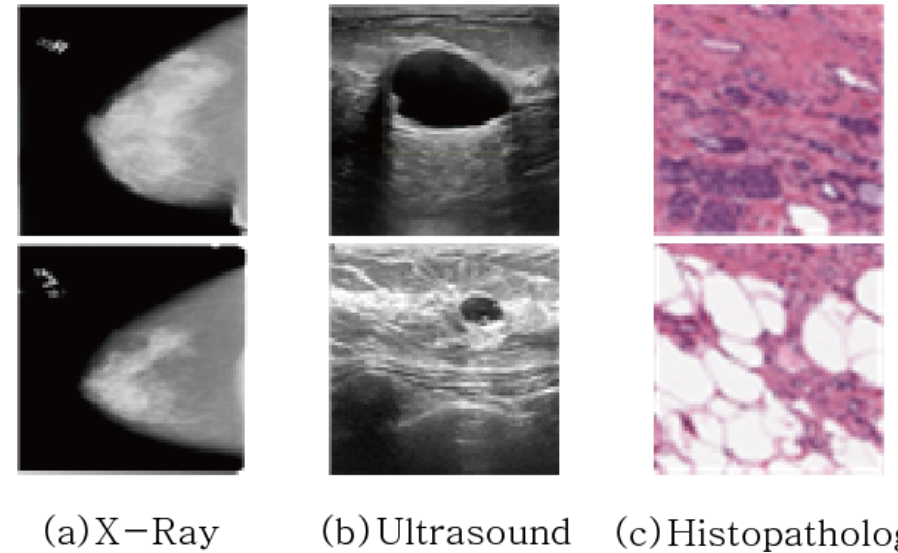
Figure 2. Example of Medical Image Data used for Breast Cancer